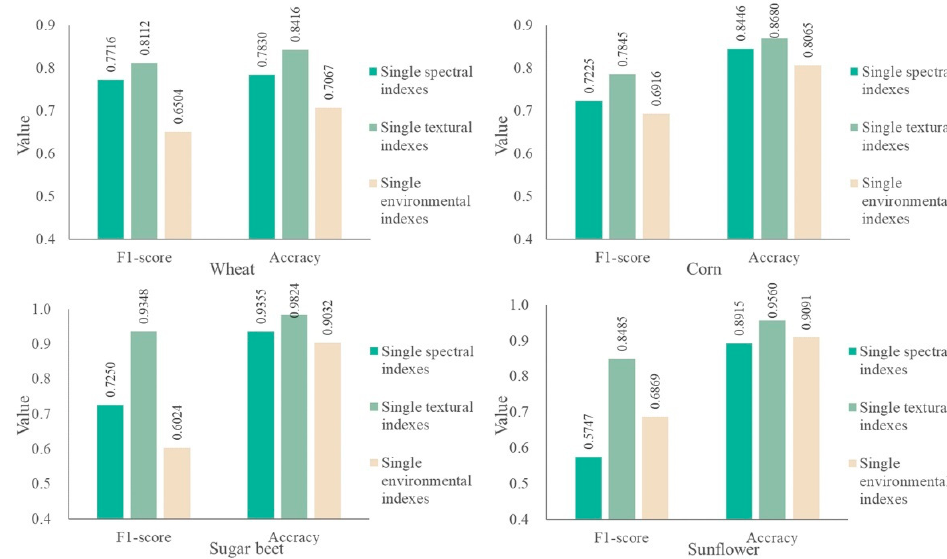
Figure 8. Classification results of individual crops under RFAA+-RF. RFAI+ = improved random forest average impurity; RF = random forest.